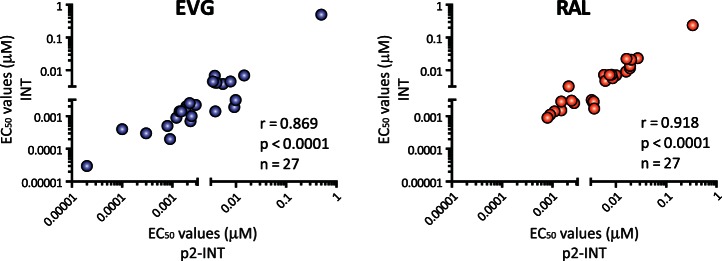
Comparing susceptibility to EVG and RAL using p2-INT- and INT-recombinant viruses.Patient-derived PCR products from 27 highly treatment-experienced individuals participating in the GS-US-183-0105 study of elvitegravir were used to construct p2-INT or INT-recombinant viruses and their susceptibility to EVG and RAL determined using VIRALARTS™HIV in triplicate. Pearson correlation coefficient was used to determine the strength of association between the EC50 values calculated using the two sets of recombinant viruses. r, correlation coefficient; p, two-tailed p value; and n, number of viruses analyzed per drug.